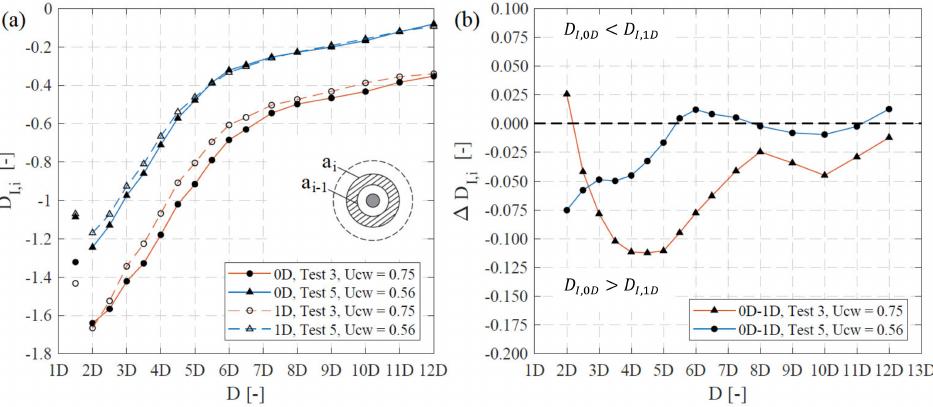
Figure 5. ( a ) The mean incremental depth D I , i of displaced sediment (Piles 1–4) calculated with Equation (5) of Tests 3 and 5, referring to 0D and 1D node distances in comparison, the sketch of increasing incremental circular interrogation areas around each pile is shown as an example for a circular area a i − a i − 1 . ( b ) Shows di ff erential values of the erosion depth between 3D scans of 0D and 1D tests, calculated according Equation